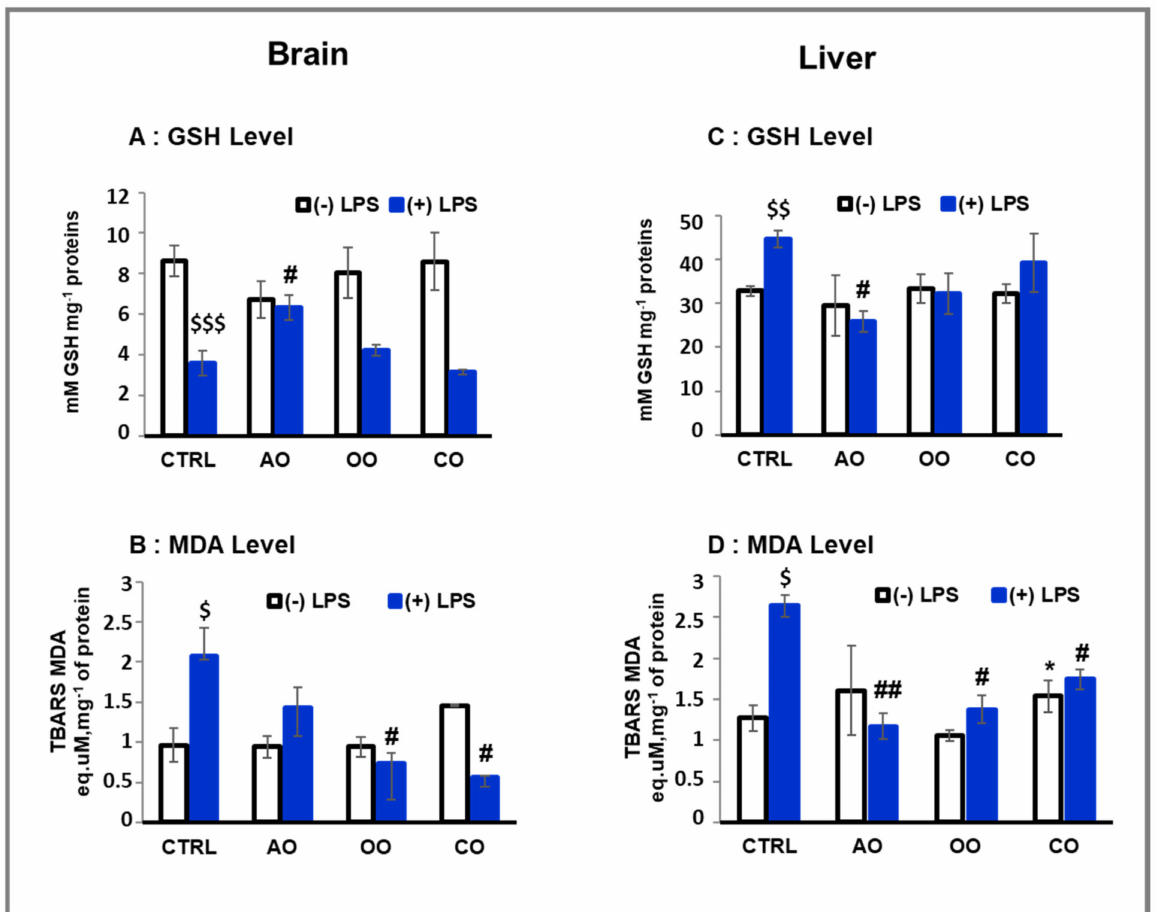
Figure 1. Effect of argan oil, olive oil, and colza oil treatments on GSH level ( A , C ) and lipid peroxida- tion ( B , D ) in brain and liver. Male C57BL/6 mice received for 28 days a standard diet (control: CTRL), a diet enriched with 6% ( w / w ) AO, OO, or CO, and an intravenous injection of LPS (100 µ g) four hours antemortem. All values are means ± SD ( n = 3), Statistical significance of higher mean signal strength (* p ≤ 0.05) compared to control, (## p ≤ 0.01, # p ≤ 0.05) compared to LPS and ($$$ p ≤ 0.001, $$ p ≤ 0.01, $ p ≤ 0.05) compared to the different treatments with or without LPS